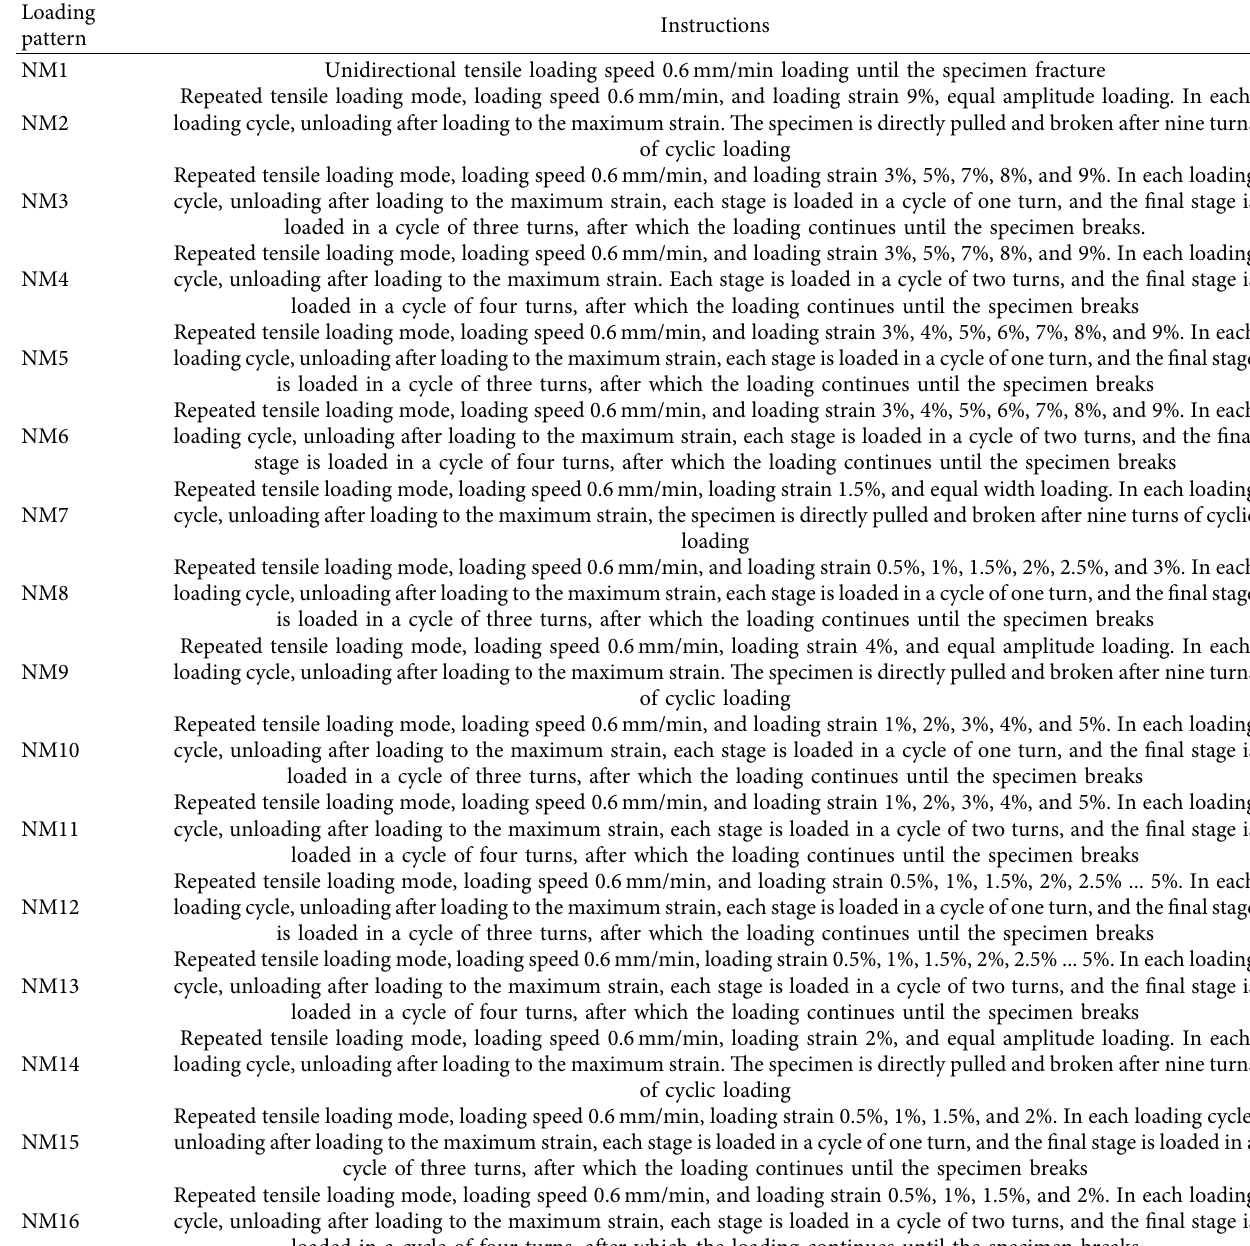
Table 4: Loading patterns of tested